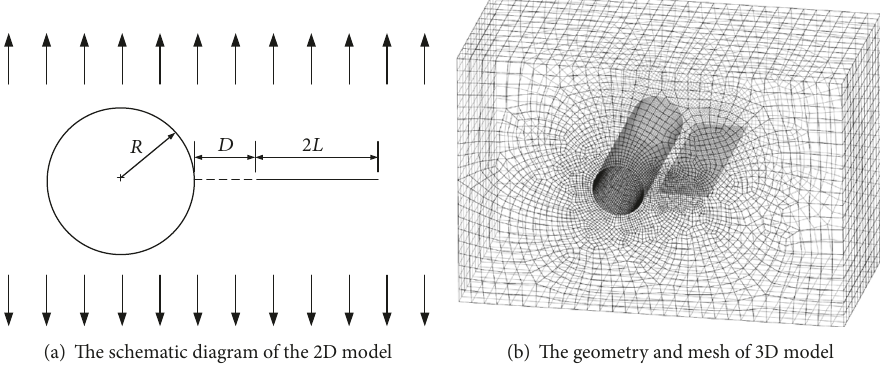
Figure 4: The schematic diagram of a crack aligned along the center of the